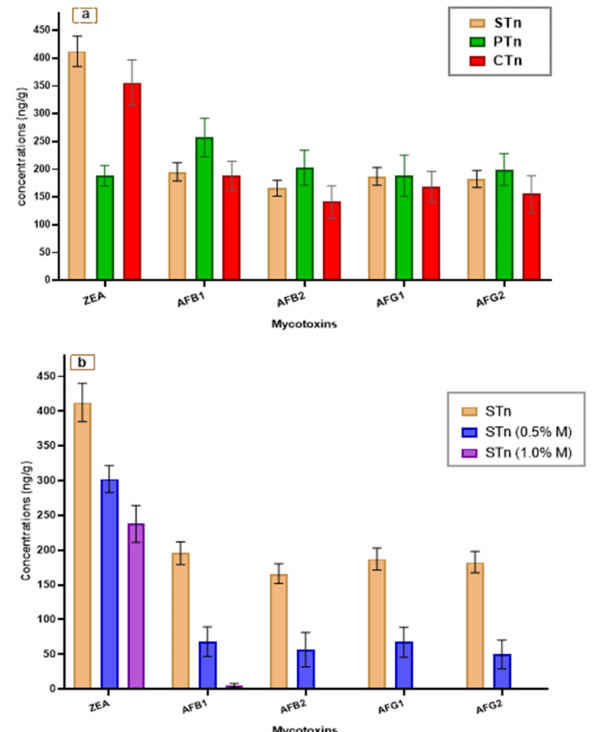
Figure 1. Mycotoxin content of survey samples and fortified samples of tahini. ( a ) Mycotoxin’s natural contamination in common tahini samples; ( b ) mycotoxin content changes after mushroom fortification in the tahini sesame model. AFB1: aflatoxin B 1 ; AFB 2 : aflatoxin B 2 ; AFG 1 : aflatoxin G 1 ; AFG 2 : aflatoxin G 2 . STn: sesame paste tahini; PTn: tahini manufactured with sesame paste containing 10% peanut paste; CTn: tahini manufactured with sesame paste containing 10% chickpea